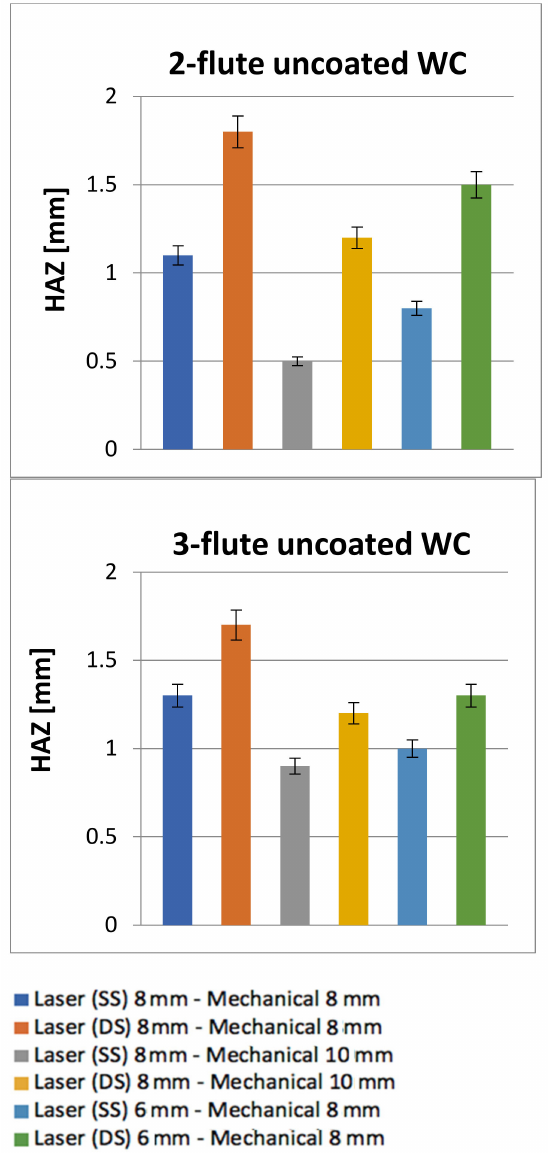
Figure 10. The results of the remaining heat-affected zones (HAZ) left after mechanical drilling. A possible way to explain these results is that the laser pre-drilling softened the matrix excessively, which prevented the matrix from properly transferring the load to the fibres. The uncut fibres became more susceptive to deformation due to a decrease in the work piece’s thickness (i.e., layers) during the second step of sequential drilling (i.e., the mechanical drilling process). Moreover, the damages were due to the nature of the drilling operation; the rotating cutting edges were constantly changing their relative positions with respect to reinforcement and advancing through the thickness helically. It is worth noting that the size of a laser pre-drilled hole is ideally reduced in order to eliminate damages (i.e., HAZ and delamination). For example, if the final diameter is 10 mm, it is advisable to reduce the laser pre-drilled hole size from 8 mm to 6 mm, which leaves 4 mm to be cut by mechanical drilling to make sure that the damages are completely removed.